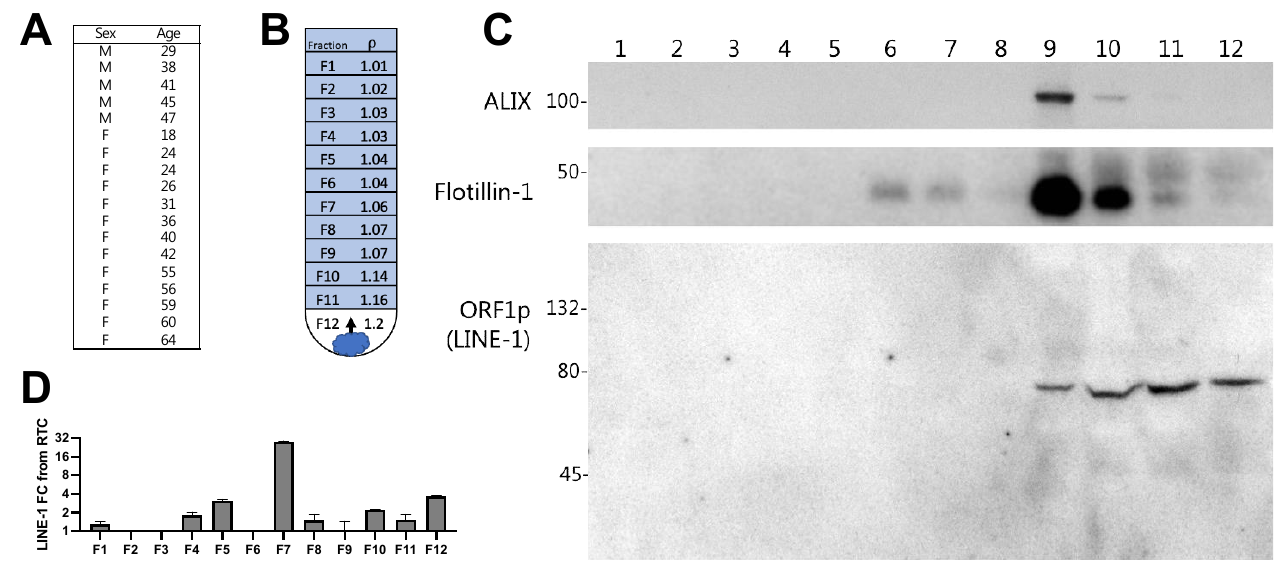
F1212481632 F1 F2 F3 F4 F5 F6 F7 F8 F9 F10 F11 Figure 4. Density gradient distribution of Long Interspersed Element-1 (LINE-1) mRNA and ORF1p in human plasma extracellular vesicles (EVs). Plasma EVs from ostensibly healthy subjects were isolated by ultracentrifugation and subjected to iodixanol buoyant density gradient ultracentrifugation. Plasma from 18 subjects (1 mL each) was pooled to increase likelihood of LINE-1 detection ( A ) Age and sex of donors. ( B ) Diagram showing how EVs rise to the gradient level equivalent to their density during the course of centrifugation. Density of 1 mL gradient fractions. ( C ) Western blot of EV proteins and the ORF1p dimer present in density gradient fractions 1 – 12. ( D ) LINE-1 mRNA present in fractions 1 – 12.